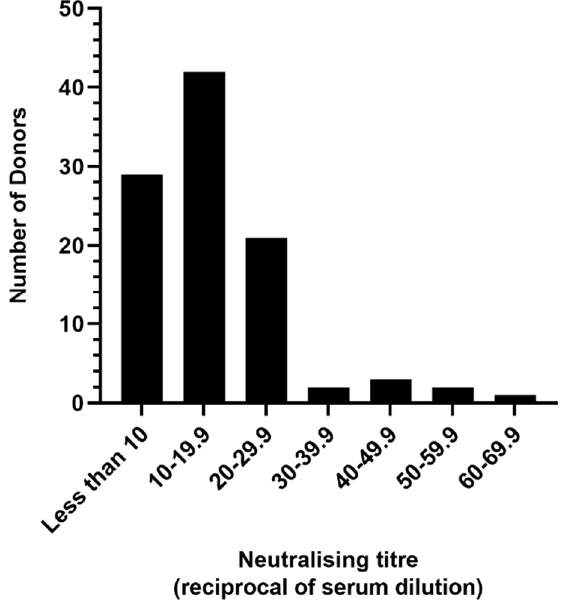
Viruses 2021 , 13 , x FOR PEER REVIEW Figure 1. Geometric mean HCoV-NL63-neutralising antibody titres in plasma from 100 adult blood donors. An NT 50 of 10 (1:10 dilution of plasma) was the limit of sensitivity for the assay.